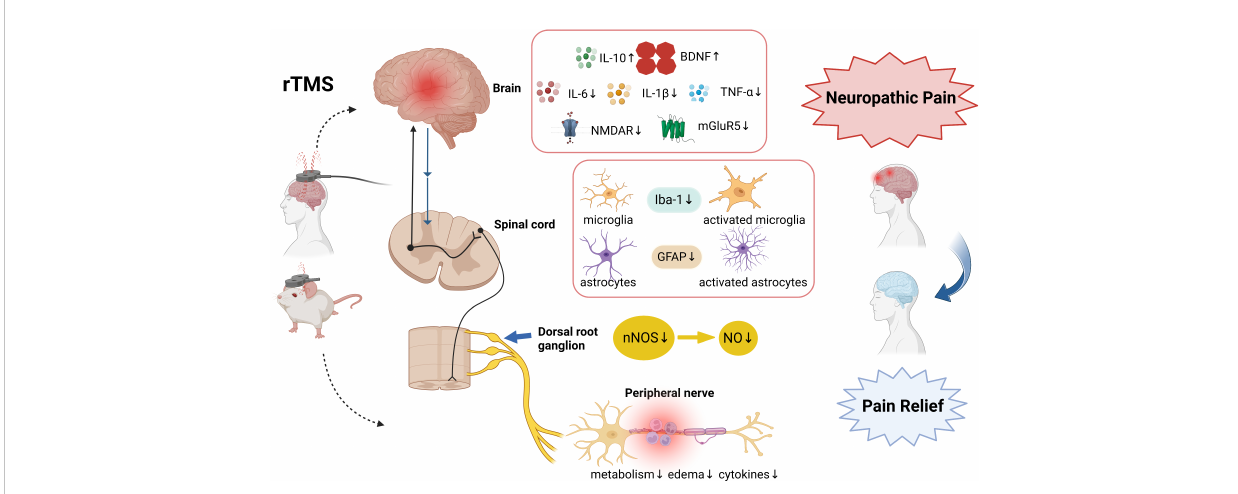
FIGURE 1 The involved mechanisms in rTMS on neuropathic pain relief. The analgesic mechanism involves neuroin fl ammatory n cytokines, glutamate receptors, microglia and astrocyte markers, nNOS, and peripheral nerve in fl ammation. Created with BioRender.com. rTMS, Repetitive Transcranial magnetic stimulation; IL-10, interleukin -10; IL-6, interleukin -6; IL-1 b , interleukin -1 b ; BDNF, brain-derived neurotrophic factor; TNF- a , tumour necrosis factor-alpha; mGluR5, metabotropic glutamate receptors 5; NMDAR2B, N-Methyl-D-Aspartic acid receptor type 2B; Iba-1, Ionized calcium- binding adapter molecule 1; GFAP, glial fi brillary acidic protein nNOS, nitric oxide synthase; NO, Nitric